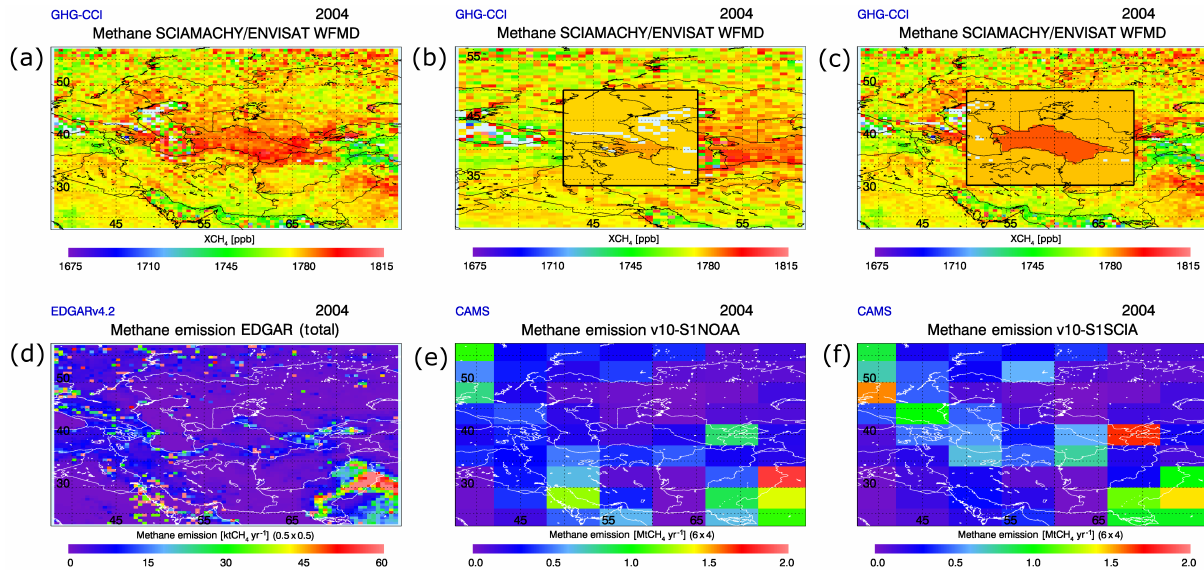
Figure 19. (a) SCIAMACHY WFMD year 2004 X CH 4 in and around Azerbaijan and Turkmenistan (resolution 0.5 ◦ × 0.5 ◦ ). (b) As (a) but showing the Azerbaijan source region (entire country of Azerbaijan) and the default background region (rectangle) (please note that this map is shifted relative to all other maps shown in this figure to place Azerbaijan in the centre of the map). (c) As (a) but showing the Turkmenistan source and default background regions. (d) EDGAR v4.2 year 2004 total anthropogenic methane emissions (at 0.5 ◦ × 0.5 ◦ resolution). (e) CAMS year 2004 total anthropogenic and natural methane emissions based on assimilation of NOAA data (at 6 ◦ × 4 ◦ resolution). (f) As (e) but with additional assimilation of SCIAMACHY IMAP X CH 4 .